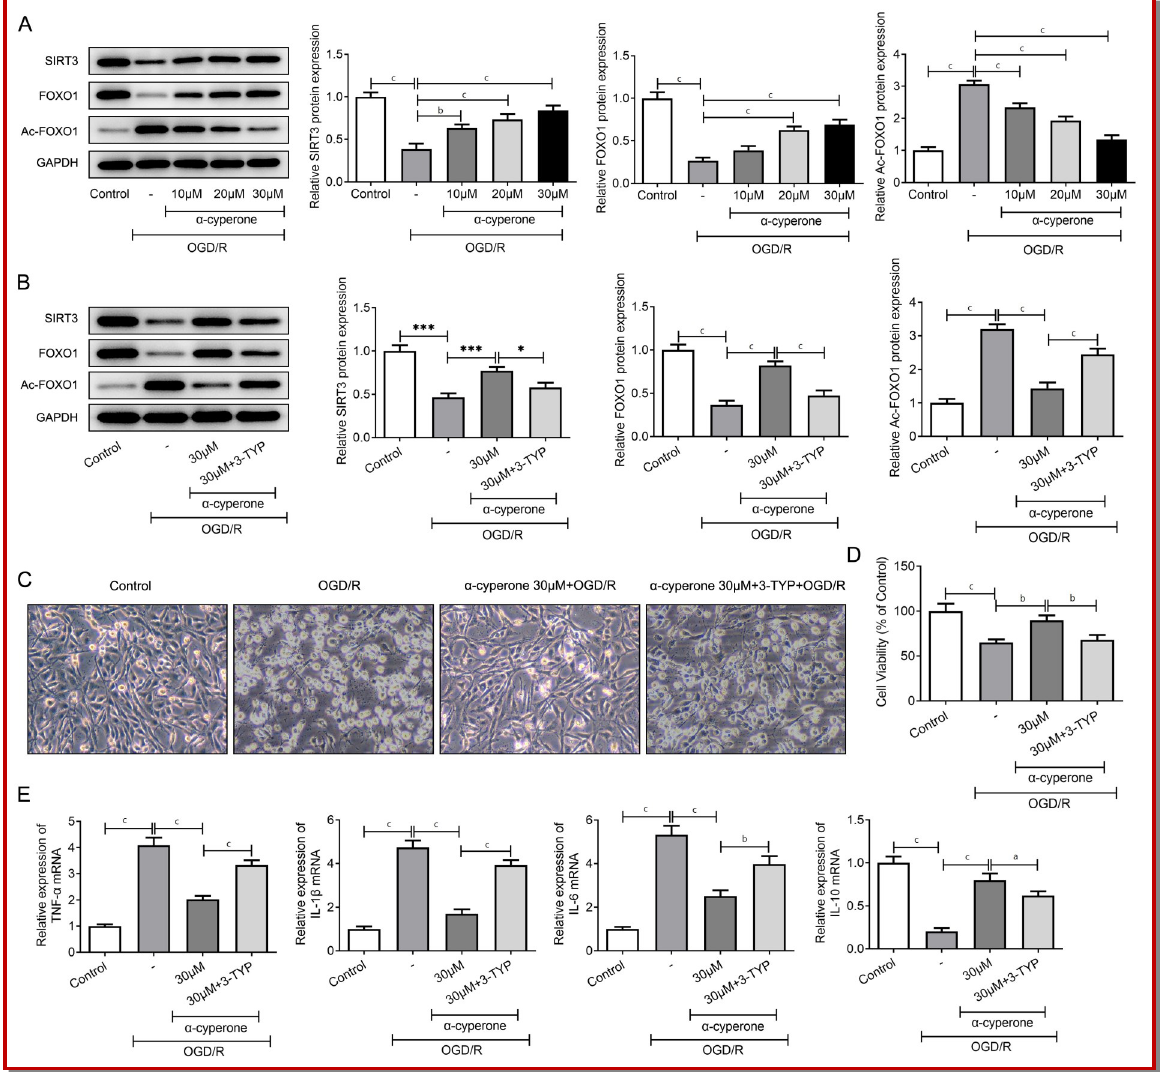
Figure 3: α -Cyperon activates SIRT3/FOXO1 signaling and 3-TYP breaks the effect of α -cyperon on neuronal viability and inflam- mation. The expression levels of SIRT3, acetyl-FOXO1 and FOXO1 were determined using western blotting (A). Following the cells were co-treated with α -cyperone and 3-TYP, the expression levels of SIRT3, acetyl-FOXO1, and FOXO1 were determined using western blotting (B). Cell viability and morphology were evaluated (C-D). The levels of inflammatory factors in the cells were determined using RT-qPCR analysis (E). a p<0.05, b p<0.01, c